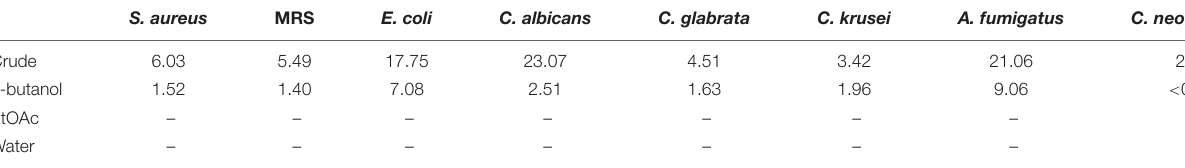
TABLE 2 | IC 50 values for the fractions resulting from the ethanol extracts in µ g/mL.